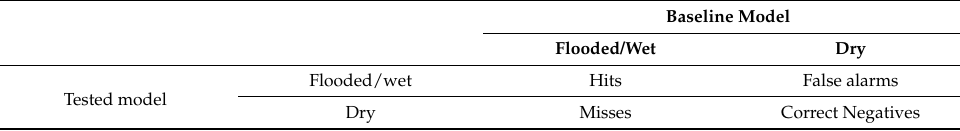
Table 1. Descriptions of the four types of parameters in the model performance evaluations.